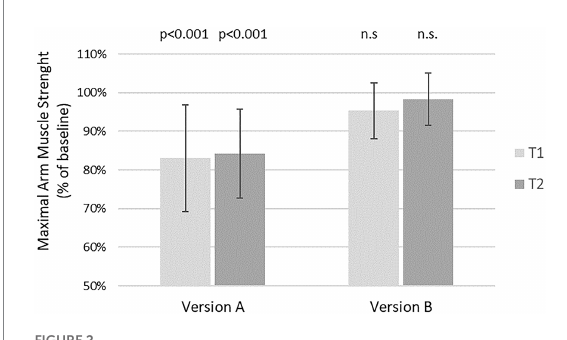
FIGURE 2 Effects of two different versions of risk disclosure on maximal